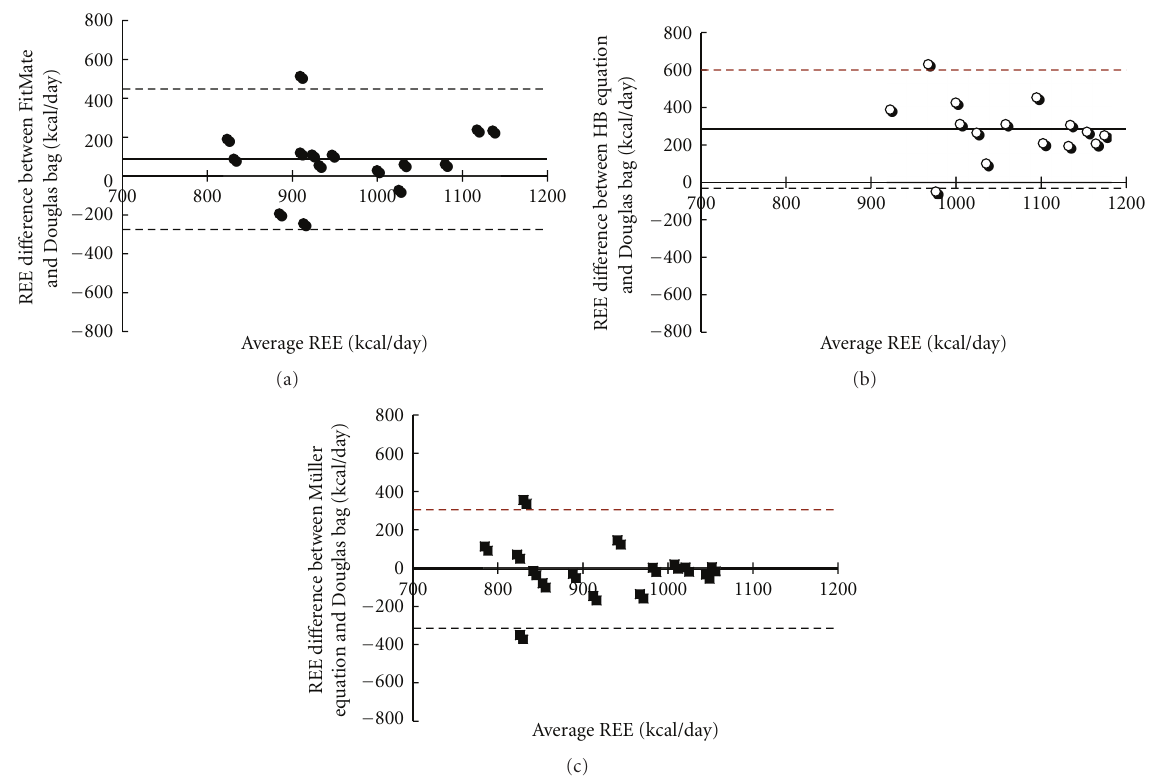
Figure 1: Bland-Altman plots: Di ff erence in the measurements of REE using: (a) FitMate and Douglas bag; (b) Harrison-Benedict equation and Douglas bag; (c) M¨uller equation and Douglas